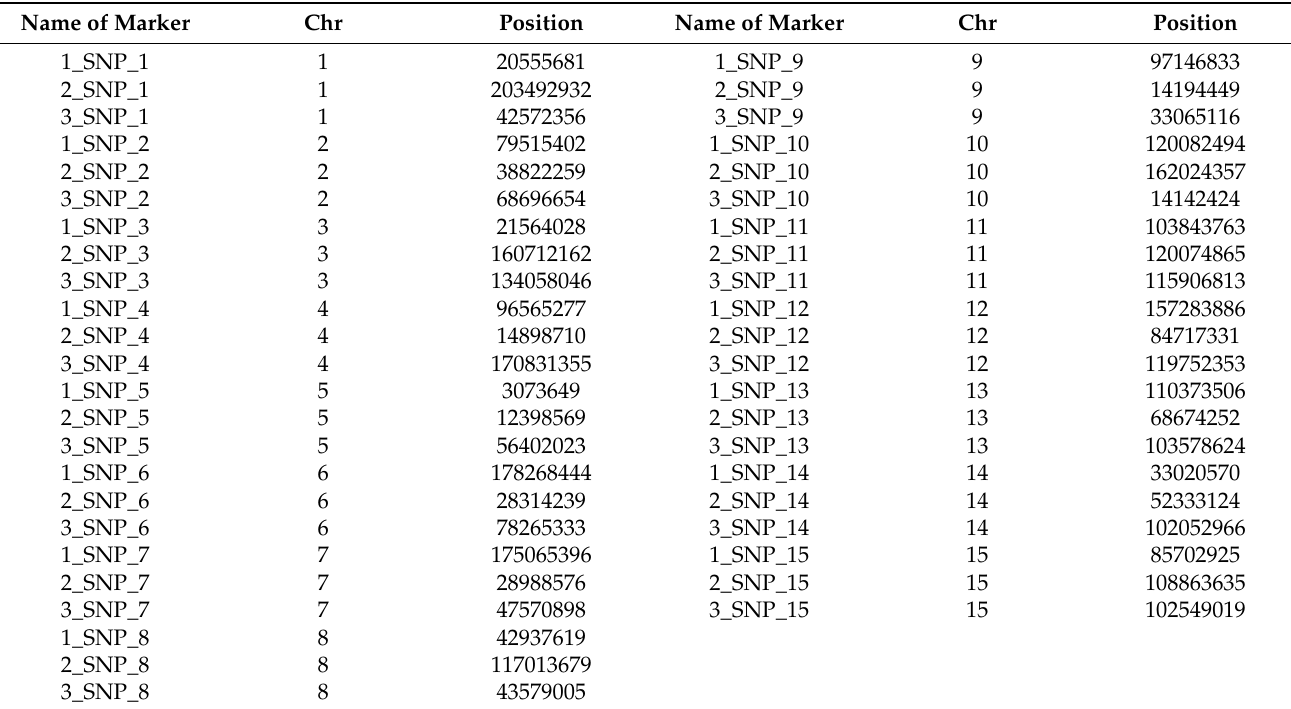
Table 1. The position of the 45 SNPs’ markers on the